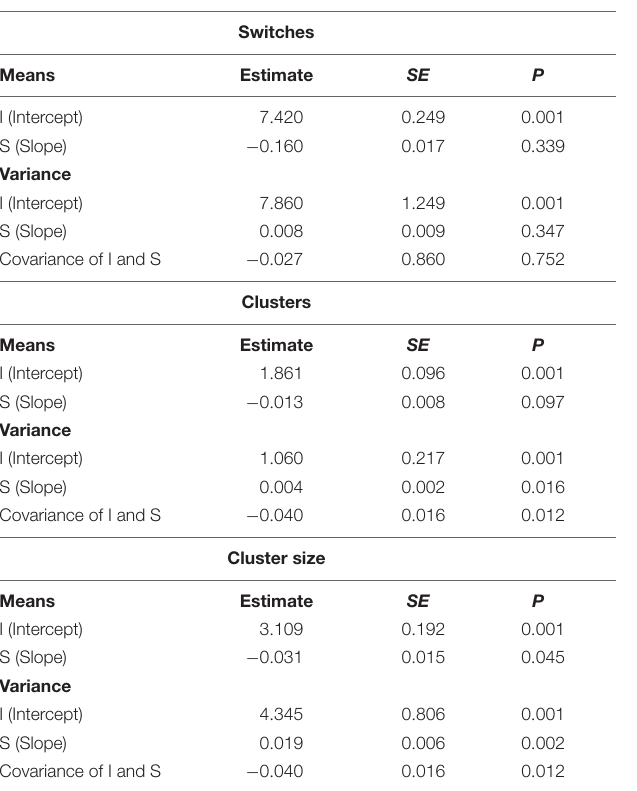
TABLE 4 | Estimates from the Unconditional LGM’s.